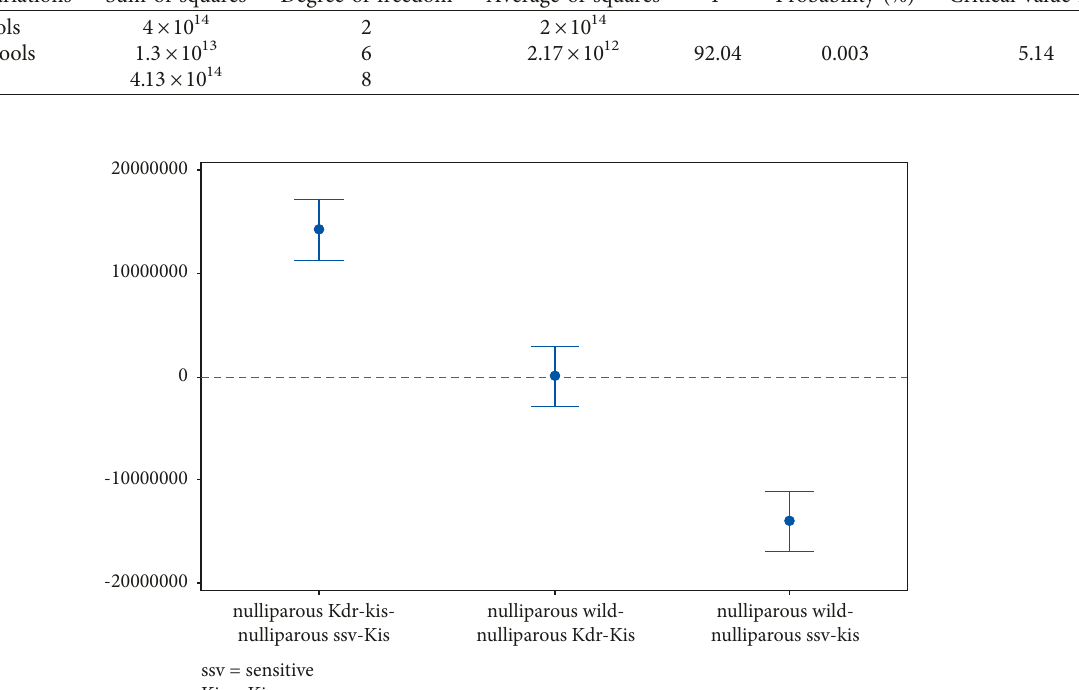
Figure 4: Graph of Fisher’s test results of gorged mosquitoes. Table 4: Results of the analysis of variance test for different Anopheles gambiae according to the category of nulliparous. Source of variations